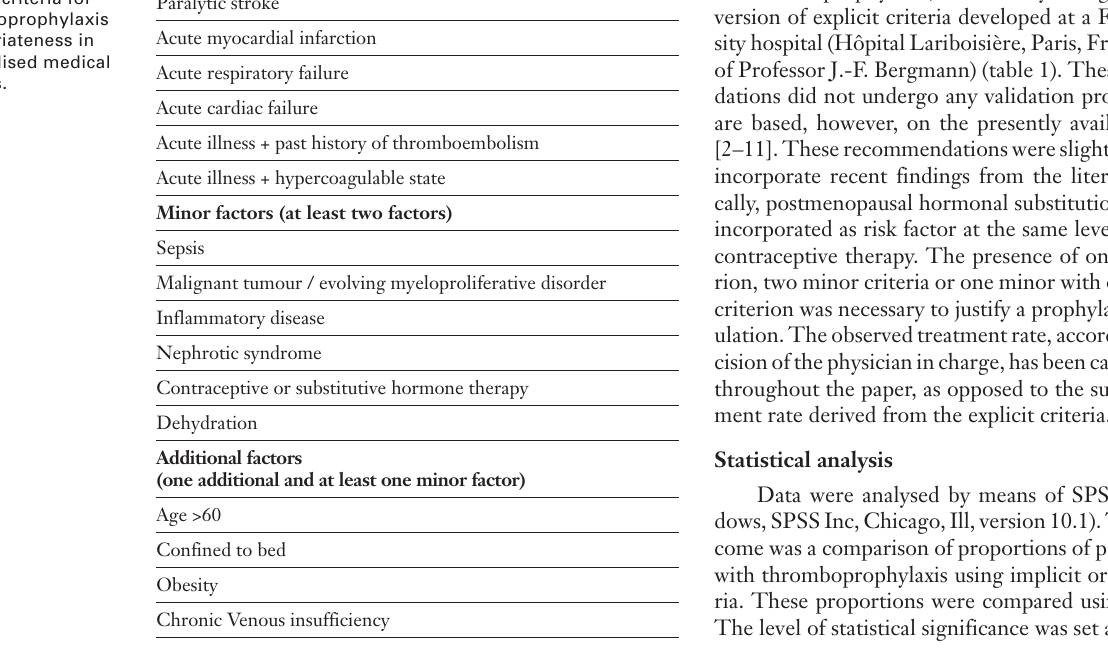
Explicit criteria for thromboprophylaxis appropriateness in hospitalised medical patients.